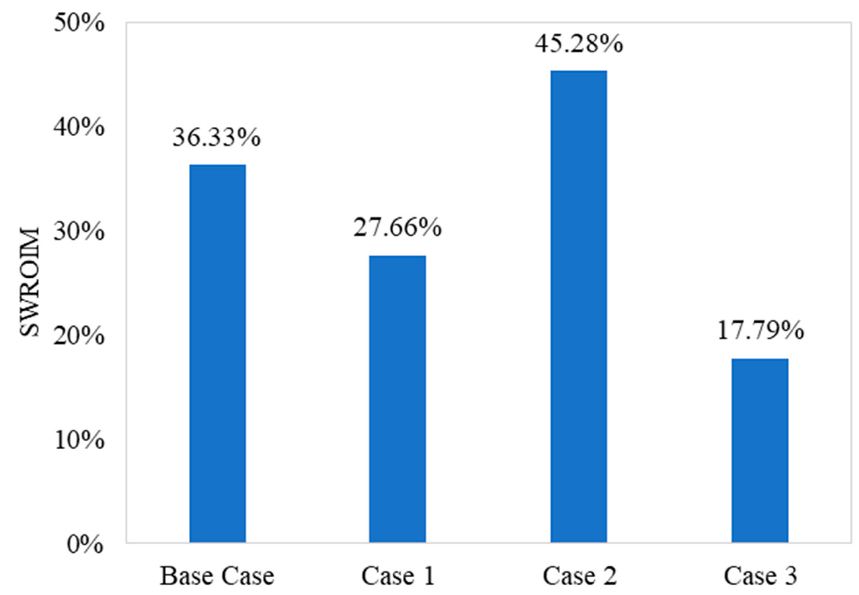
Figure 11. SWROIM sensibility analysis.